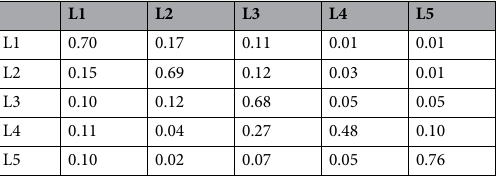
Table 2. Estimated transition matrix at round 10 in the heterogeneous treatment, considering only rounds with r = 2. Although only the odd rounds are characterized by r = 2, the statistical model extrapolates the data so that a comparison between the treatments can be done consistently.